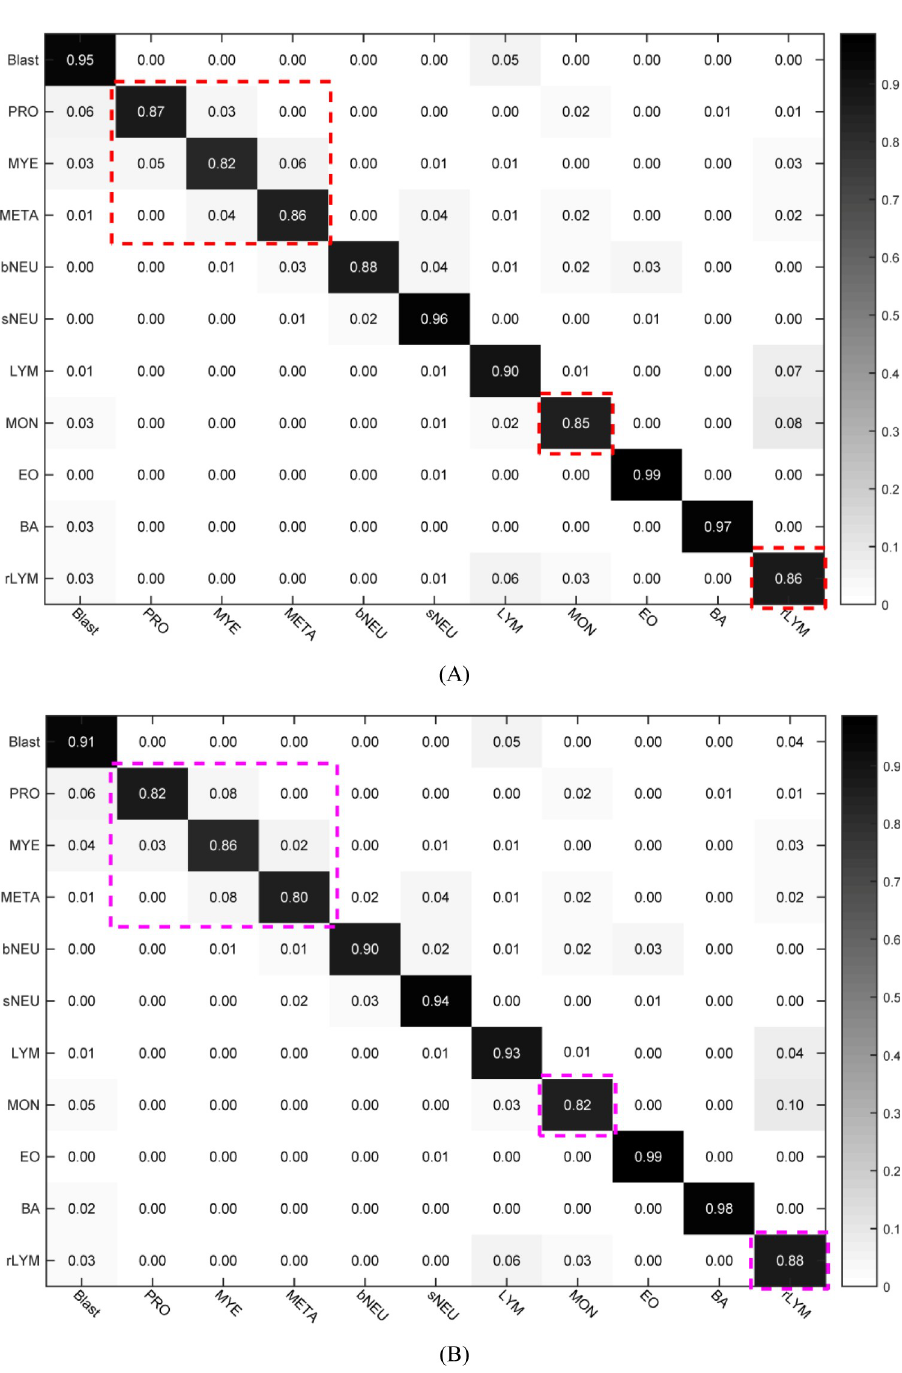
Fig 10. Confusion matrix for selected top-2 models with the 7868 image as classification test set. (A) confusion matrix for SSD300 × 300_Smin = 0.2 model with the mean accuracy of 90.09%; (B) confusion matrix for YOLOv3_320 × 320 model with the mean accuracy of